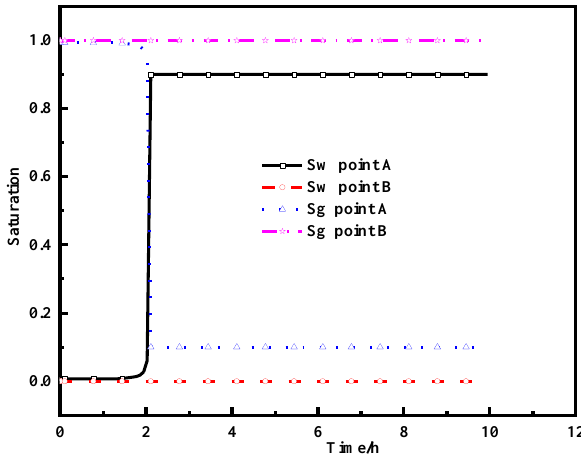
Figure 8. Changes in water and gas saturation at different points during the water injection phase.